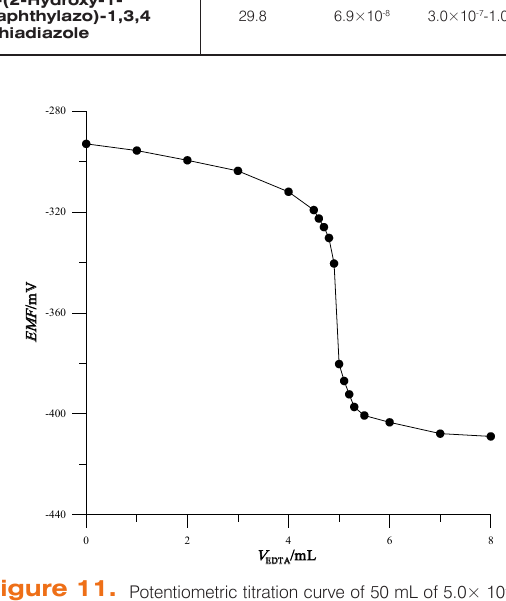
Figure 12. Time-dependent potential traces during the standard addition measurements: a- unspiked tap water sample, b- unspiked sample after standard addition (1 mL of 5.0× 10 -4 M Zn(NO Zn 2+ , d- tap water+2.5 µM Zn 2+ after standard addition (1 mL 1.0× 10 -3 M Zn(NO